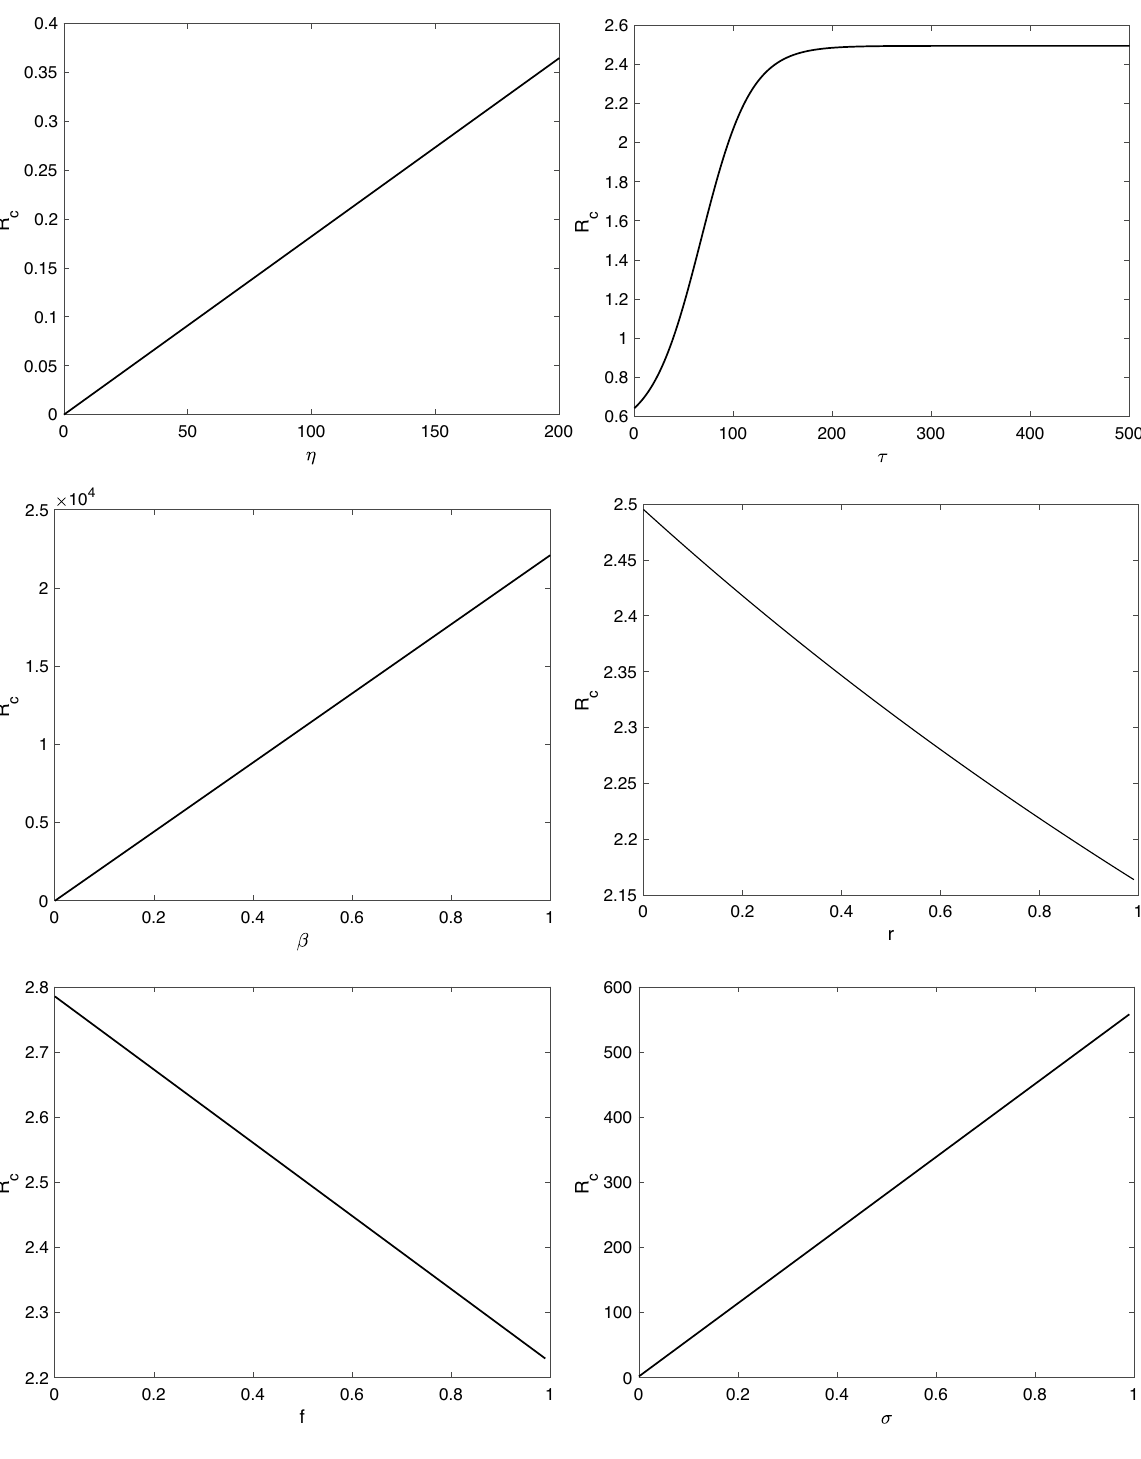
Figure 9. The sensitivity of R c of system (7) with respect to the parameters η , τ , β , r , f , and σ